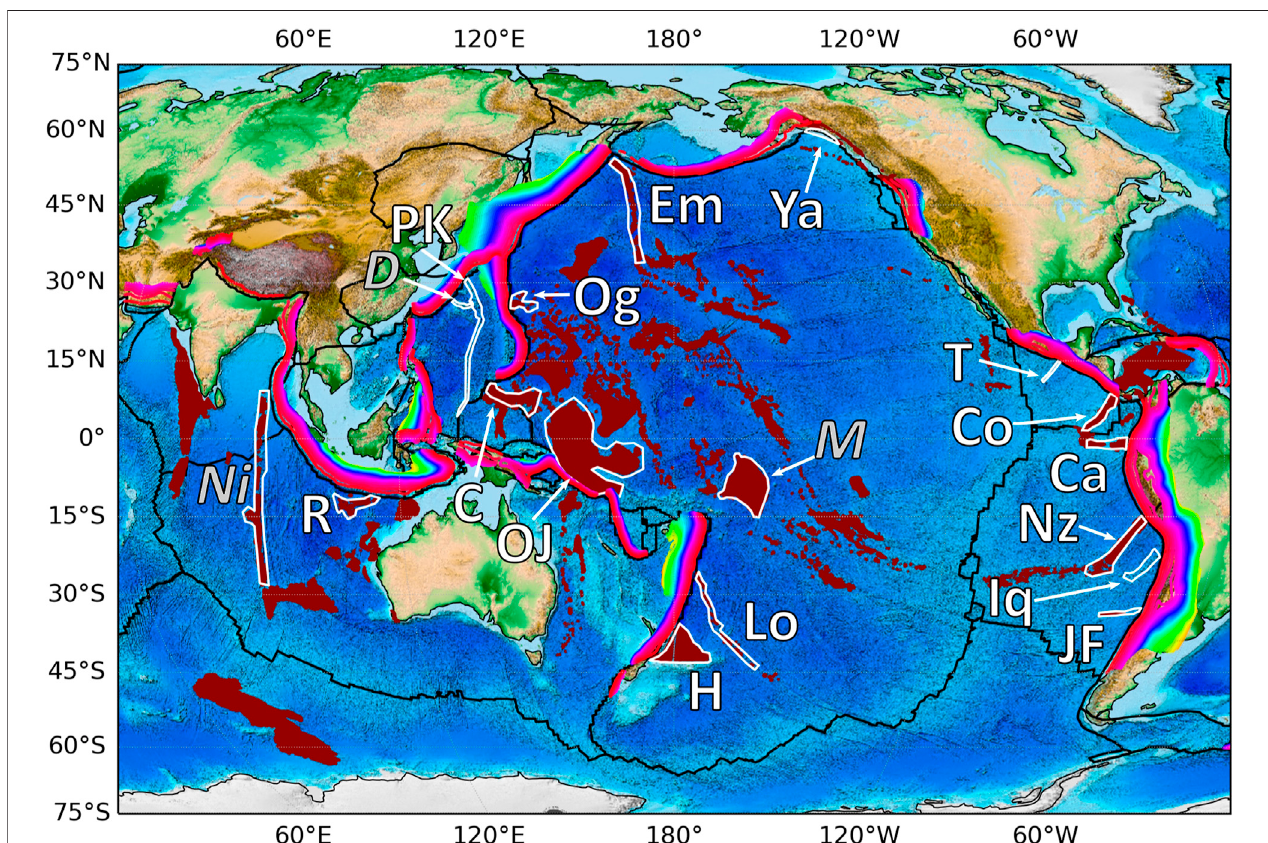
FIGURE 7 | Map of buoyant features (white outlined polygons) interacting with subduction zones in the Paci fi c and Indian oceans. Maroon surfaces indicate oceanic large igneous provinces (LIPs) and volcanic island chains. Slab depth contours are marked in RBG colours. Black lines indicate plate boundaries. Abbreviations for buoyant features discussed in the main text (white text): C — Caroline ridge, Ca — Carnegie ridge, Co — Cocos ridge, Em — Emperor ridge, H — Hikurangi plateau, Iq — Iquique ridge, JF — Juan-Fernandez ridge, Lo — Louisville ridge, Nz — Nazca ridge, OJ — Ontong Java plateau, Og — Ogasawara plateau, PK — Palau-Kyushu ridge, R — Roo rise, T — Tehuantepec ridge, Ya — Yakutat block. Other features (italic grey text): D — Daito ridge, M — Manihiki plateau, Ni — Ninetyeast ridge. Data from Cof fi netal.(2006);SkinnerandClayton(2011);TetreaultandBuiter(2014),plateboundariesafterBird(2003),bathymetricdatafromAmanteandEakins(2008)andslab depth data from Hayes et al.